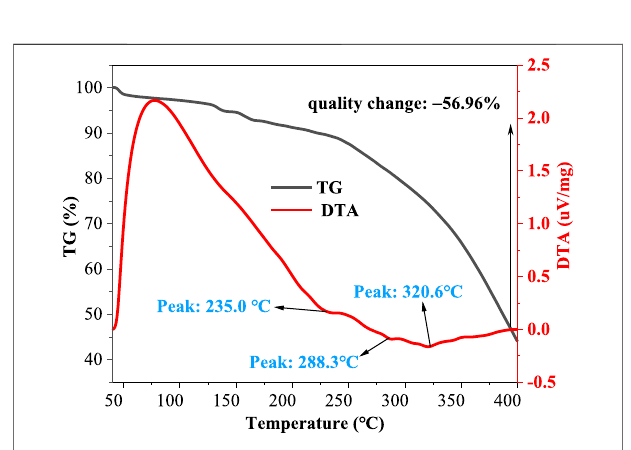
FIGURE 6 | Thermal analysis diagram of